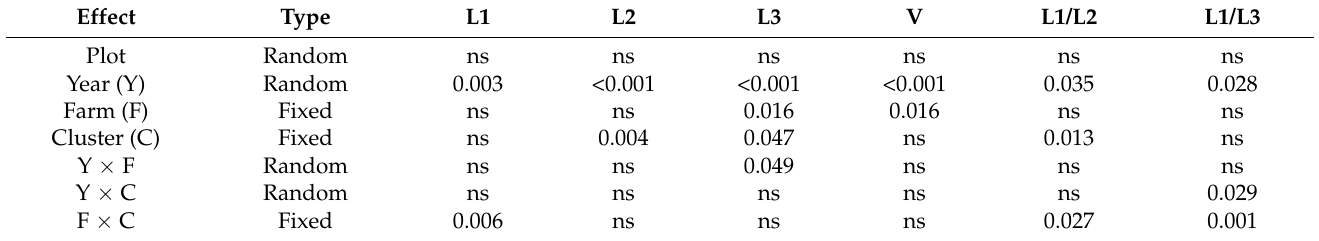
Table 5. Results of the ANOVA performed on morphometric data from the in situ